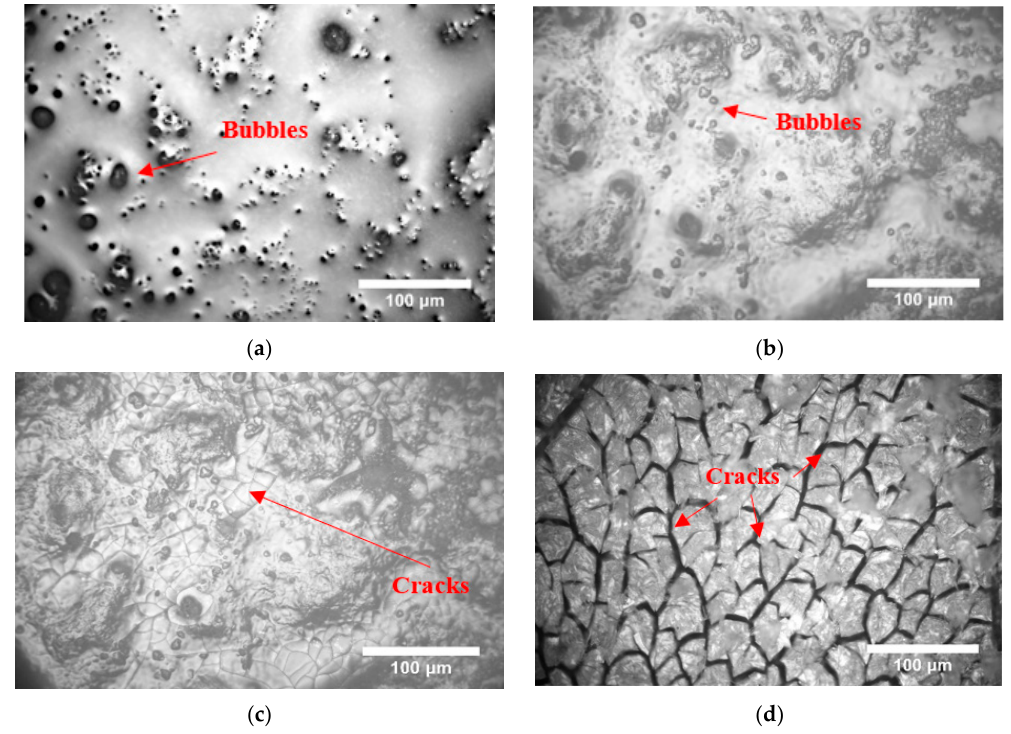
Figure 2. Surface morphology of polysilazane (PSZ) coating during heating taken by CCD camera: ( a ) 70 °C; ( b ) 150 °C; ( c ) 570 °C; and ( d ) 700 °C.